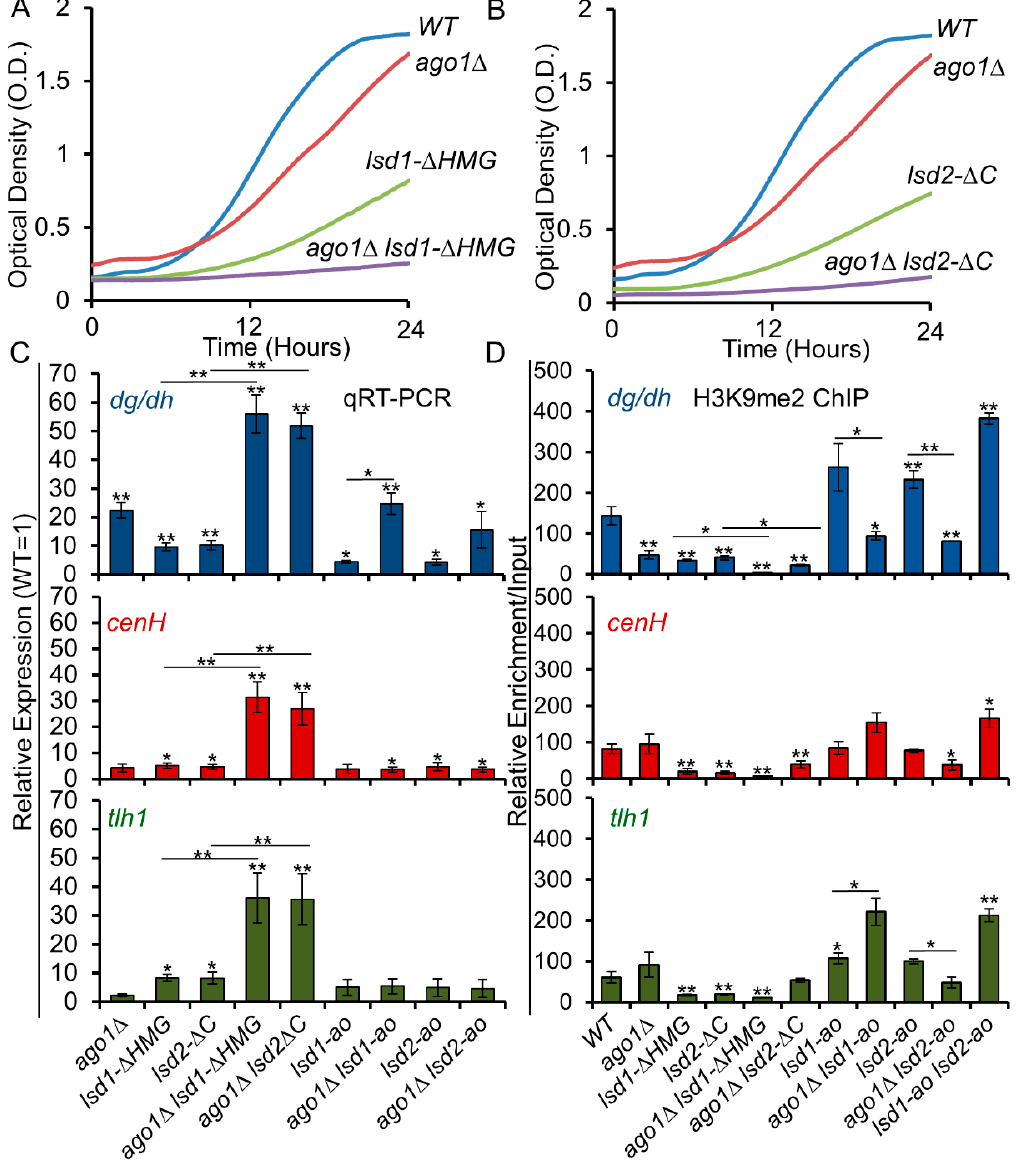
Figure 4 . The silencing defects of RNAi mutant ago1 Δ are suppressed by Lsd1/2 amine oxidase mutants, but are exacerbated by Lsd1/2 C-terminal mutants. ( A , B ) Growth curves generated by a plate reader over a 24 hour period show the genetic interactions between lsd1 and lsd2 C-terminal truncated strains combined with ago1 Δ . (C-D) qRT-PCR ( C ) and qChIP ( D ) analyses of silent dg/dh repeats (centromeric) , cenH (mating-type locus), and tlh1 (telomeric) regions demonstrate the genetic interactions between ago1 Δ and lsd mutants. * p ≤ 0.05 and ** p ≤ 0.01 as determined by student’s t test comparing the indicated samples with WT for qPCR or qChIP and by horizontal lines linking the two samples. Error bars represent s.e.m.